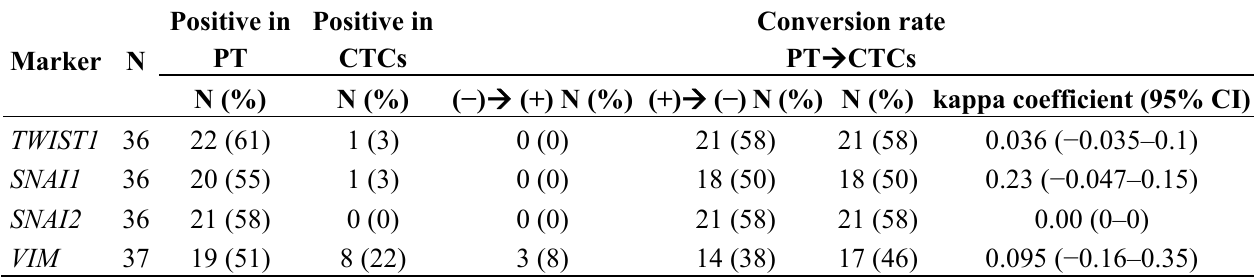
Table 7. Biomarkers’ conversion rate between paired PT and CTCs-EBF. Conversion described as the number (percentage) of discordant cases and kappa coefficient of